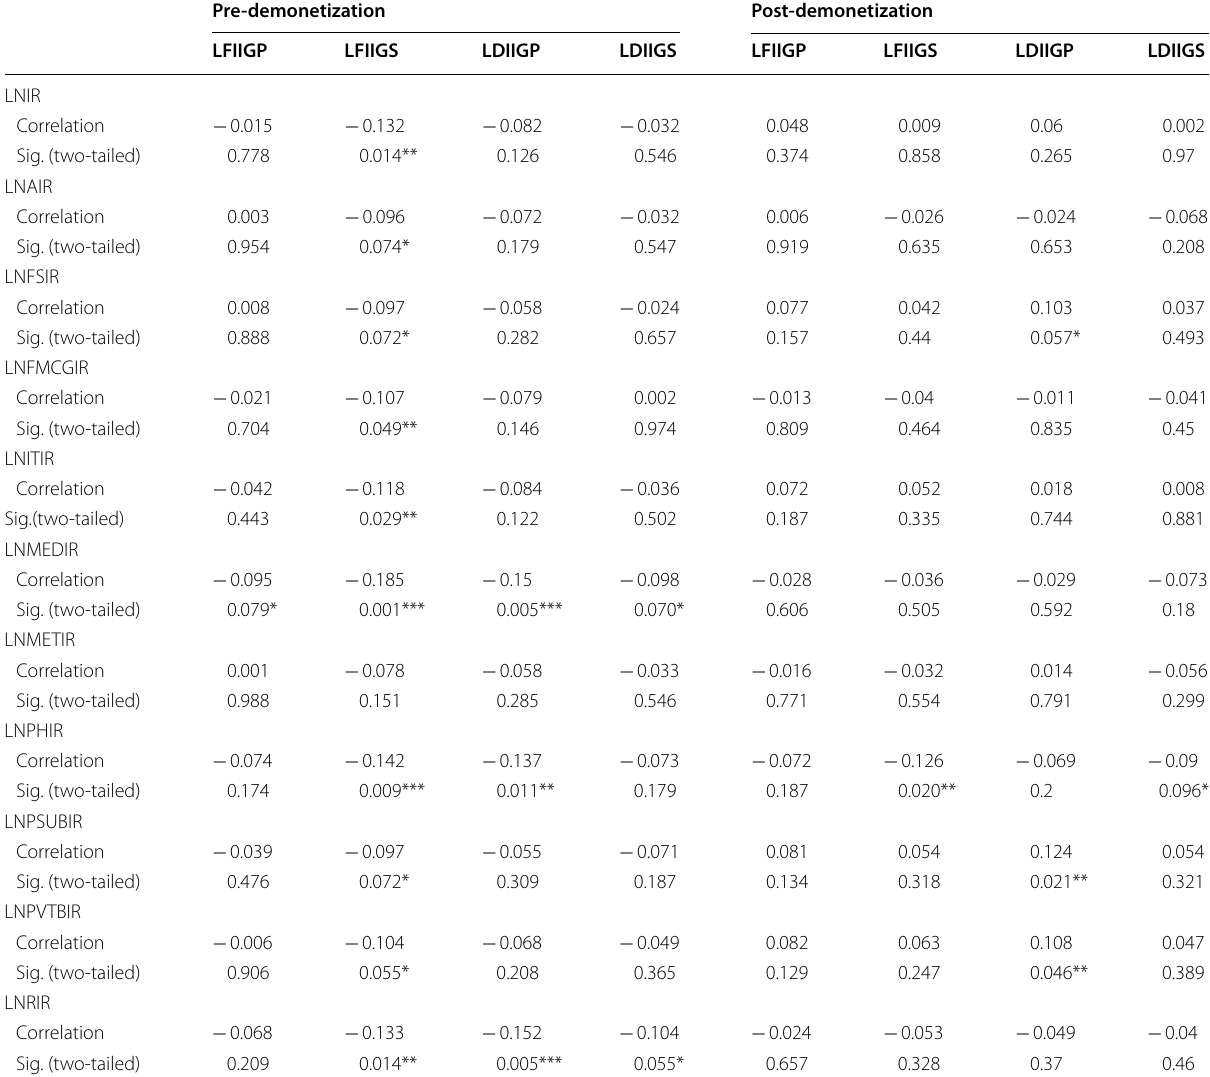
Table 3 Analysis showing relationship of FIIs and DIIs with stock market returns. Source : Author’s